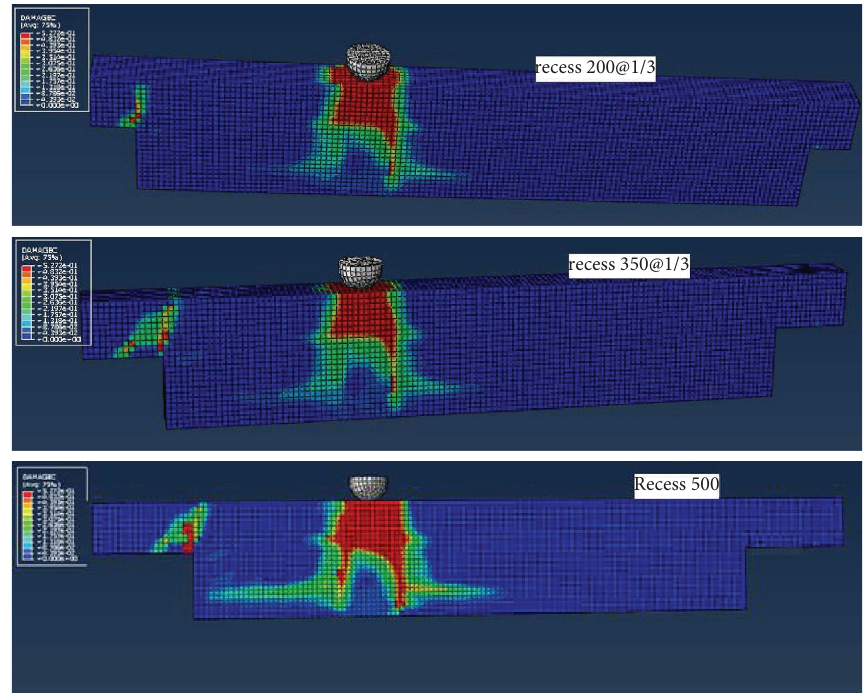
Figure 10: Damage behavior under diferent recess length.